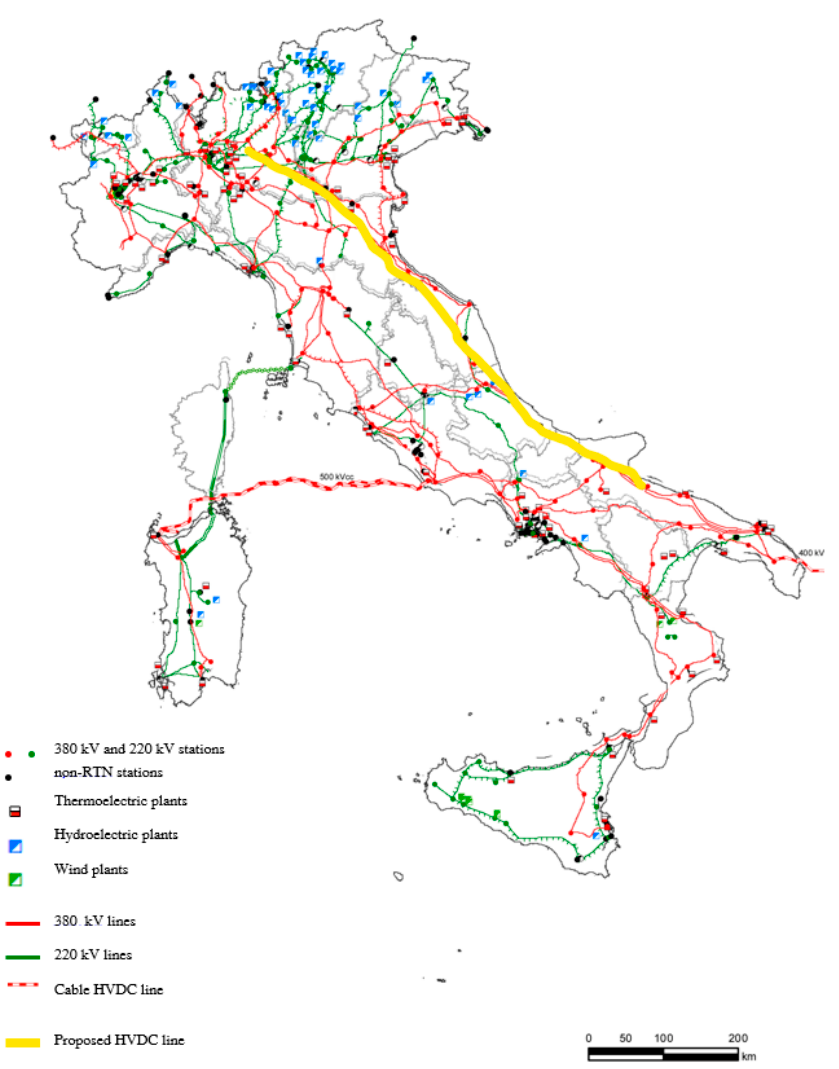
Figure 13. Hypothetical path of the proposed HVDC line.